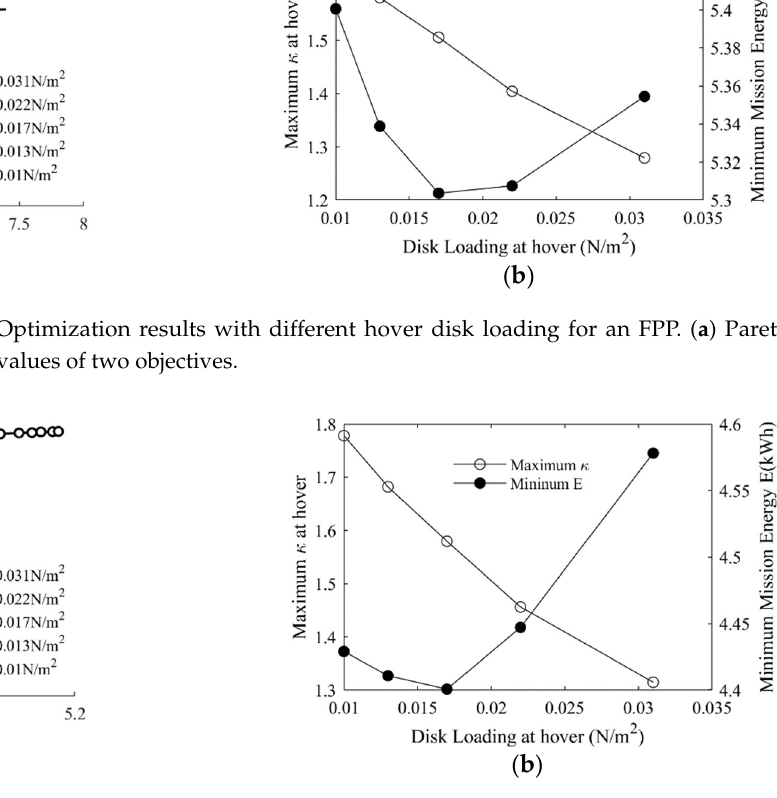
Figure 28. Optimization results with different hover disk loading for a VPP. ( a ) Pareto fronts; ( b ) extreme values of two objectives.